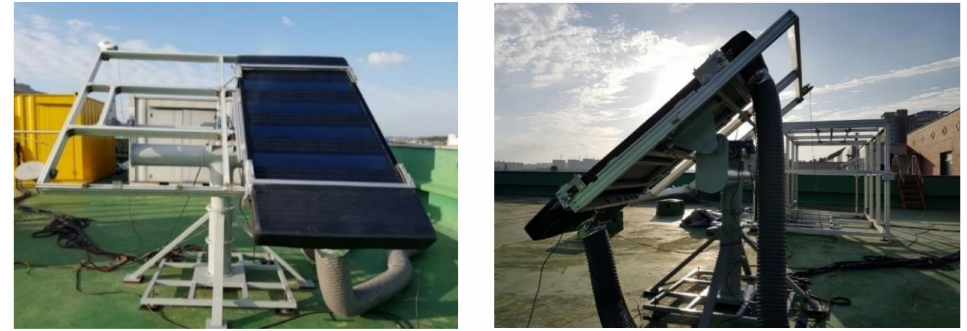
Figure 2. Outdoor experimental setup of Air-type PVT collector. From [22].